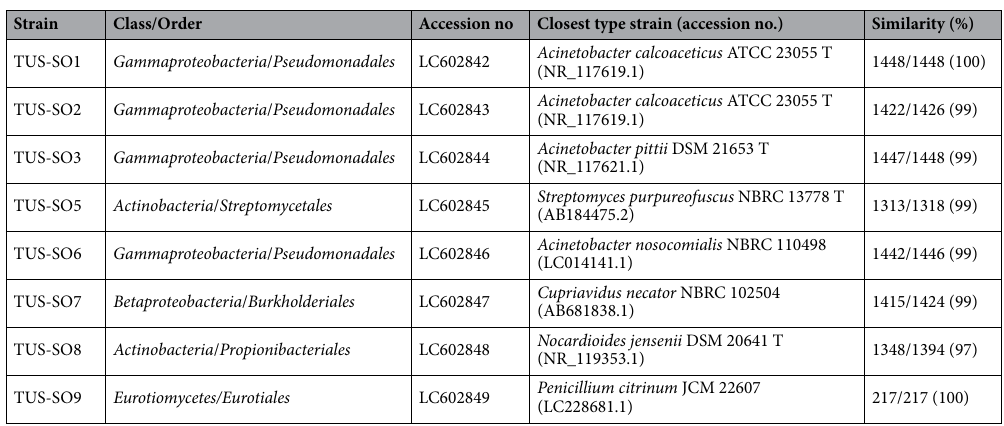
Table 1. 2-PAP–transforming microorganisms isolated in this study.